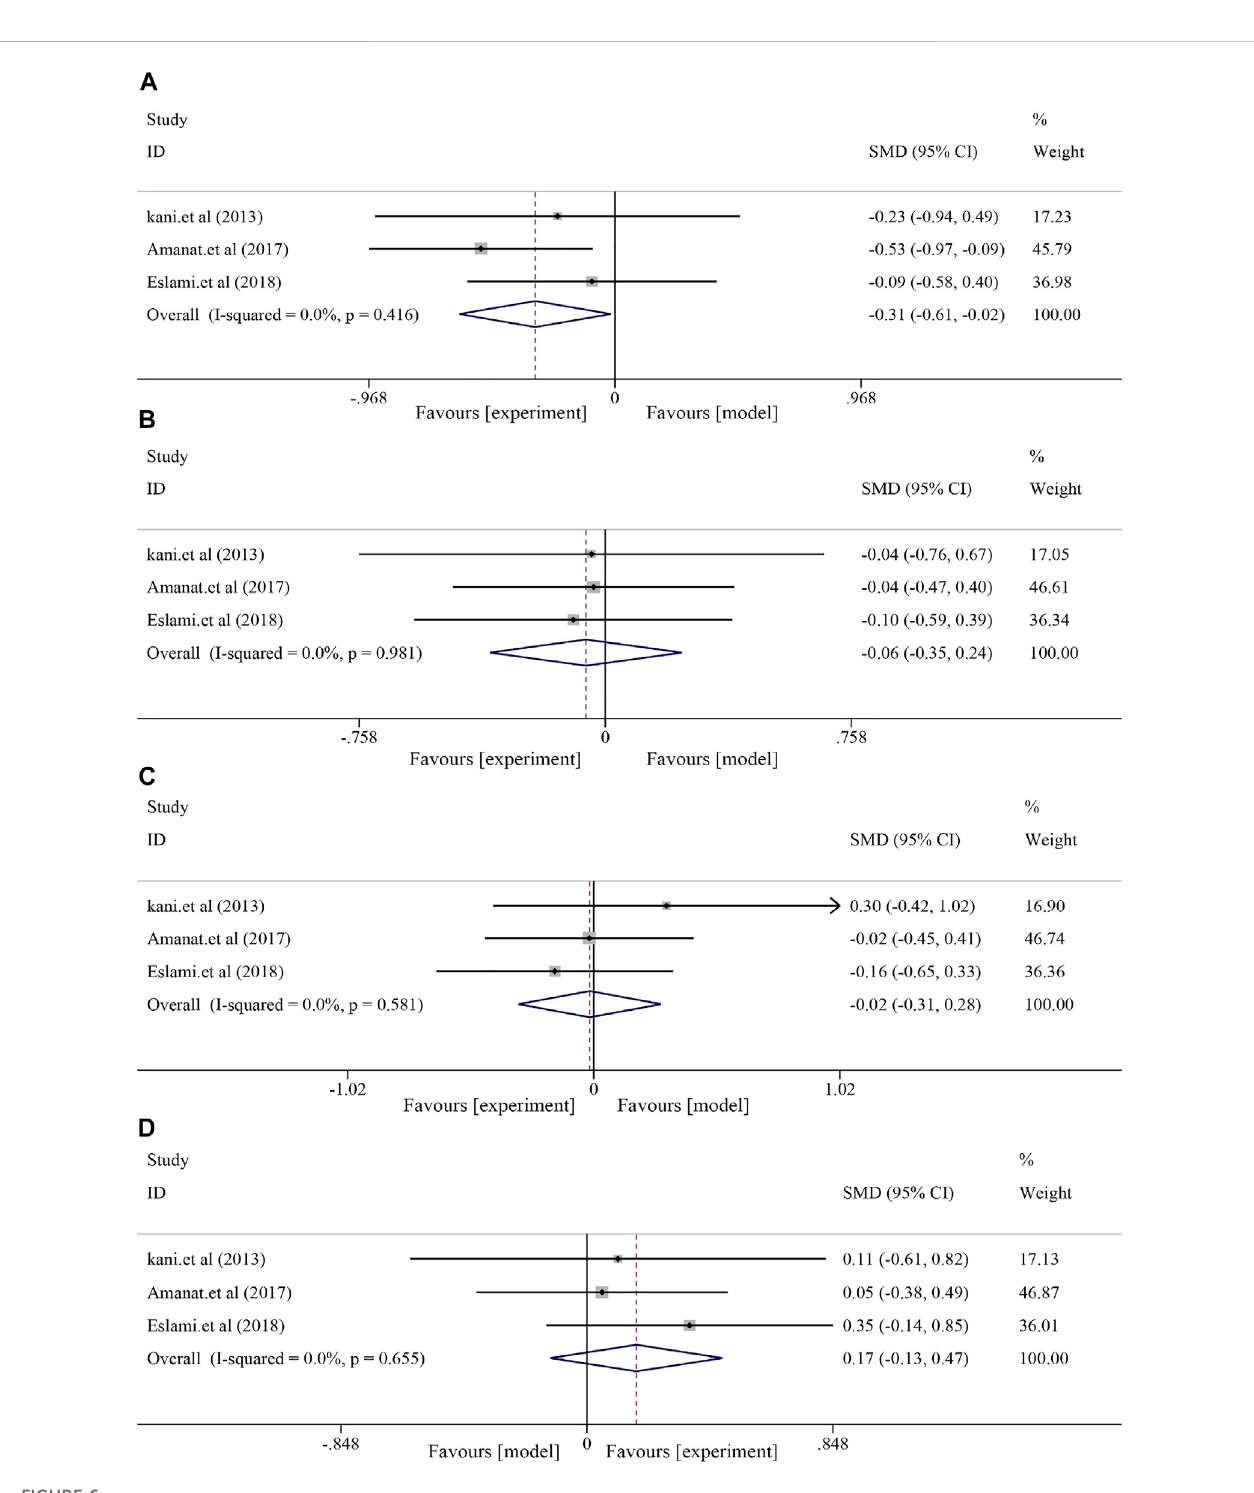
FIGURE 6 Effect of soybean on TG, TC, LDL, and HDL levels in clinical studies. (A) Pooled effects of TG, (B) TC, (C) LDL, and (D) HDL.